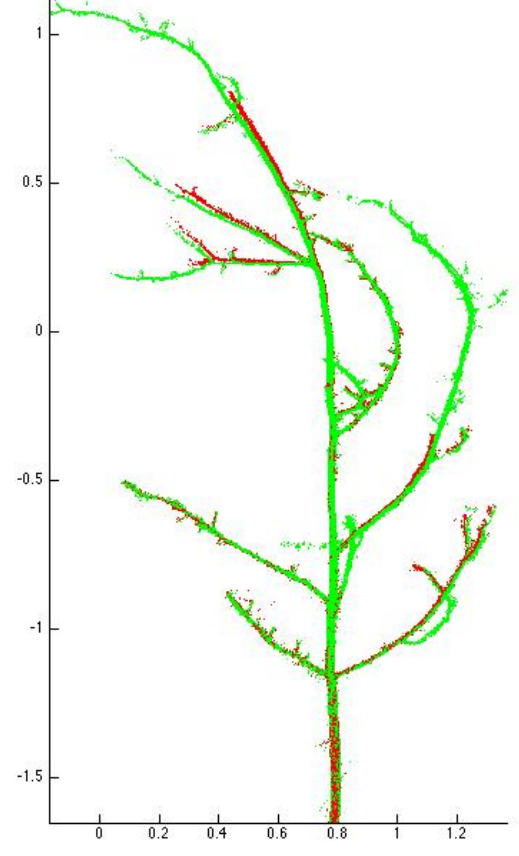
Figure 2. TLS point clouds of the aspen branch: the original branch (green) and that after the last (third) cut (red). The point cloud has been plotted into an xyz-coordinate system to show the scaling (in (metres)).